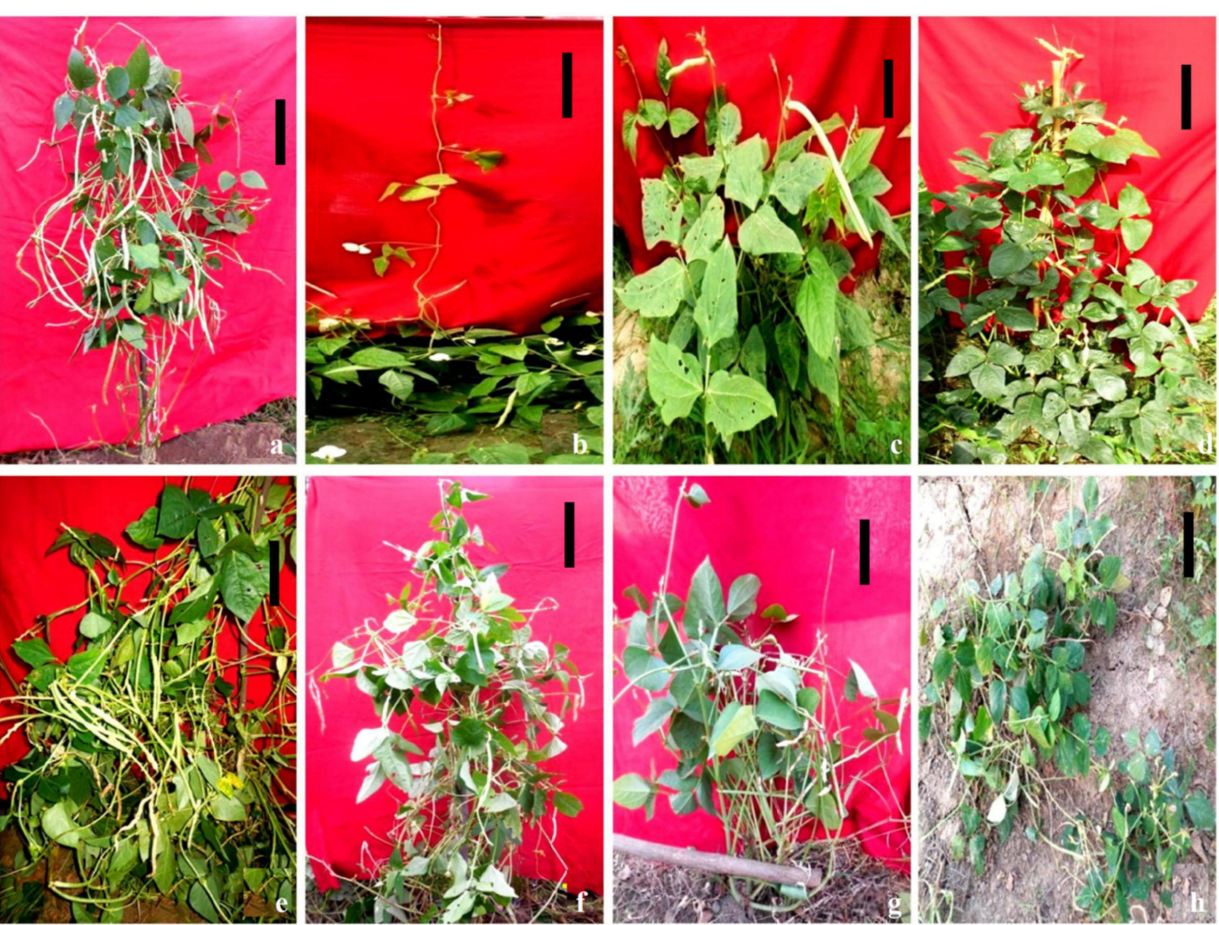
Figure 6. Representative photographs of gamma rays and sodium azide-induced alterations in plant height and growth habits. ( a ) Control plant, ( b ) tall mutant, ( c ) dwarf mutant, ( d ) semi-dwarf mutant, ( e ) semi-dwarf spreading mutant, ( f ) bushy mutant, ( g ) axillary branched mutant, and ( h ) prostrate mutant. Scale Bar = 30